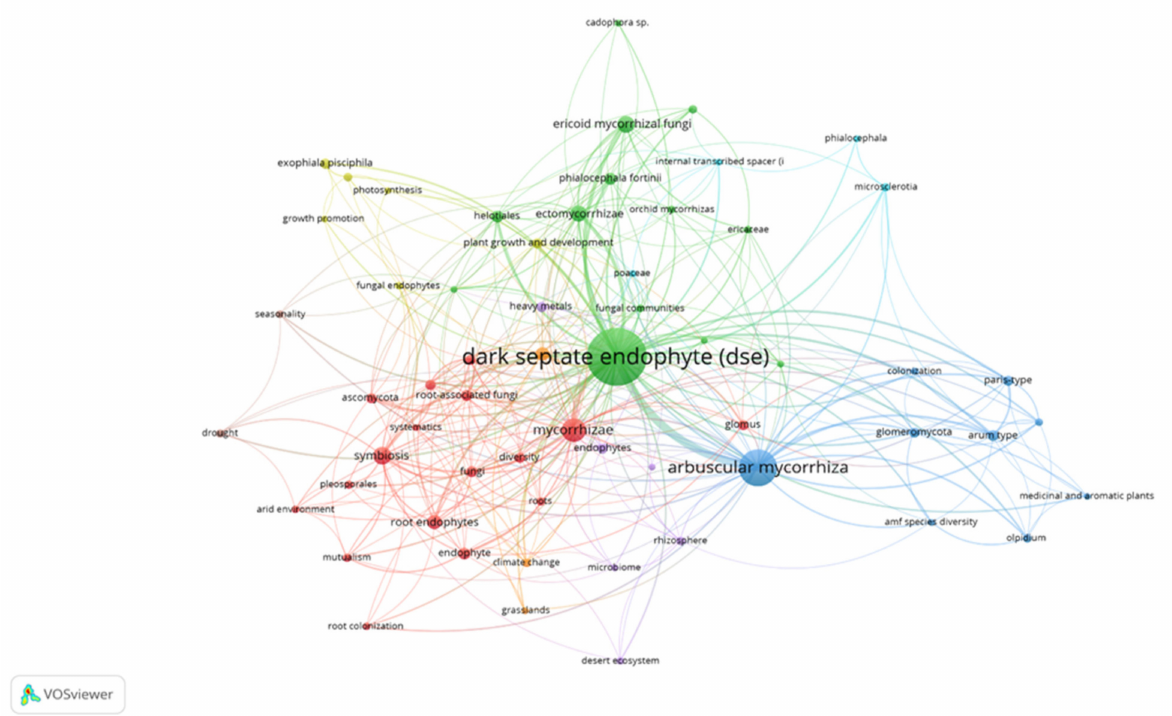
Figure 1. Network map of the co-occurrence matrix for the 547 documents published in DSE research. VOSviewer software (version 1.6.15, Leiden University, The Netherlands) was used to map the frequency of keyword co-occurrence networks. Differences in font size imply differences in relevance. The different colours refer to the groups or clusters